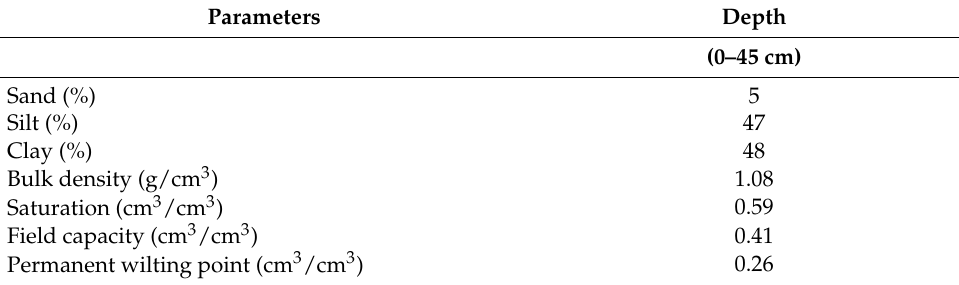
Table 2. Soil physical parameters at the experimental